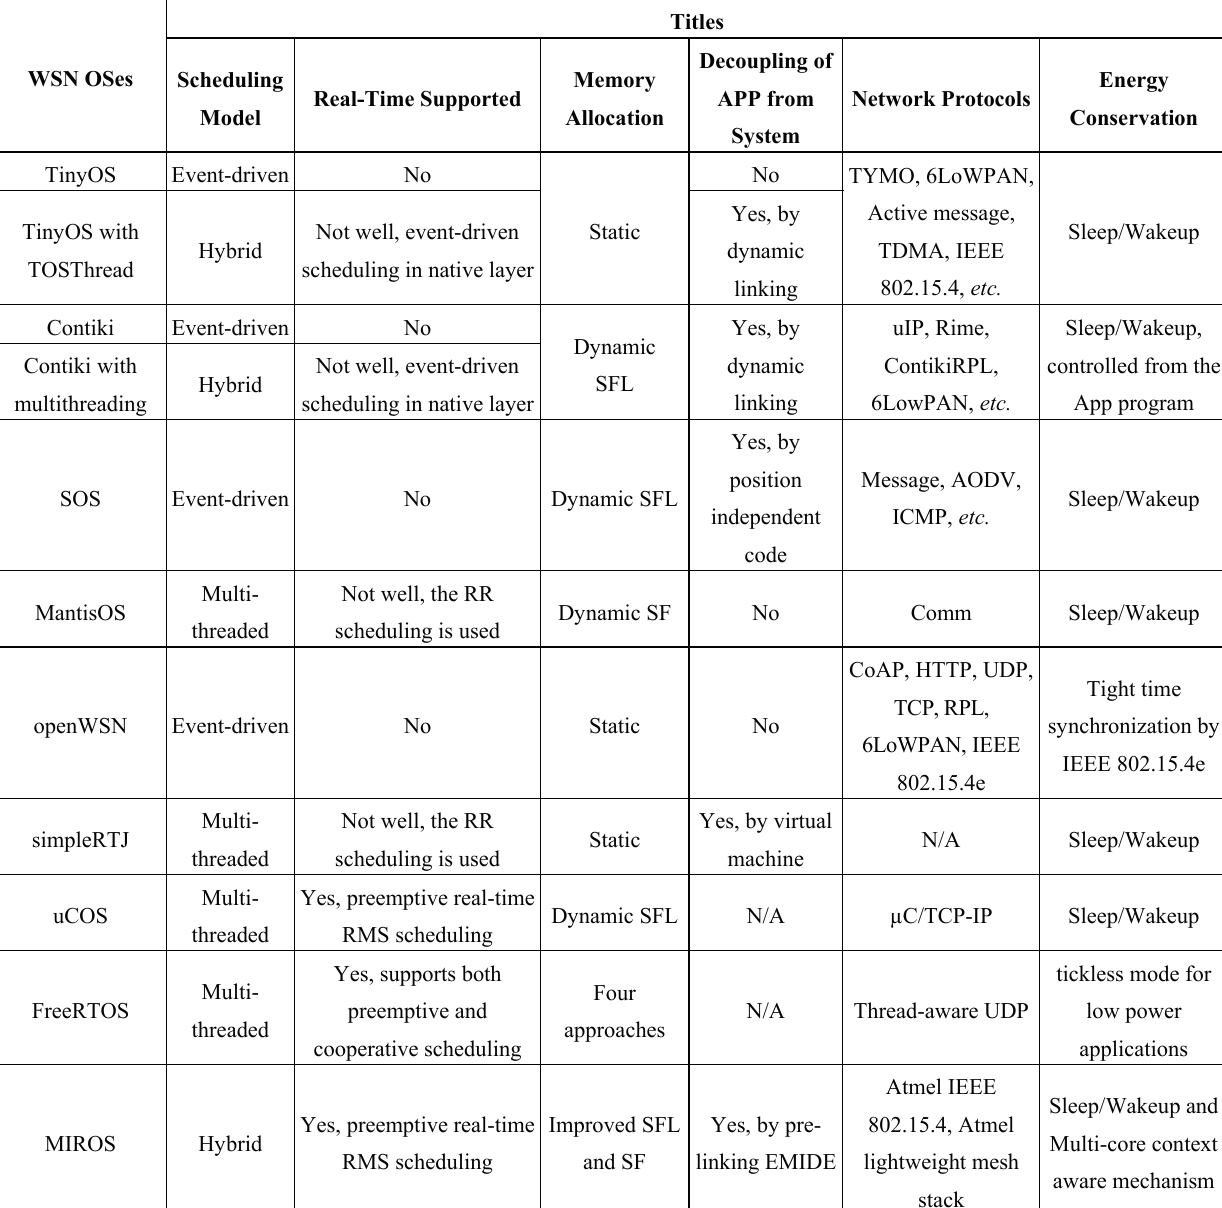
Table 12. Feature comparison of the different embedded OSes.